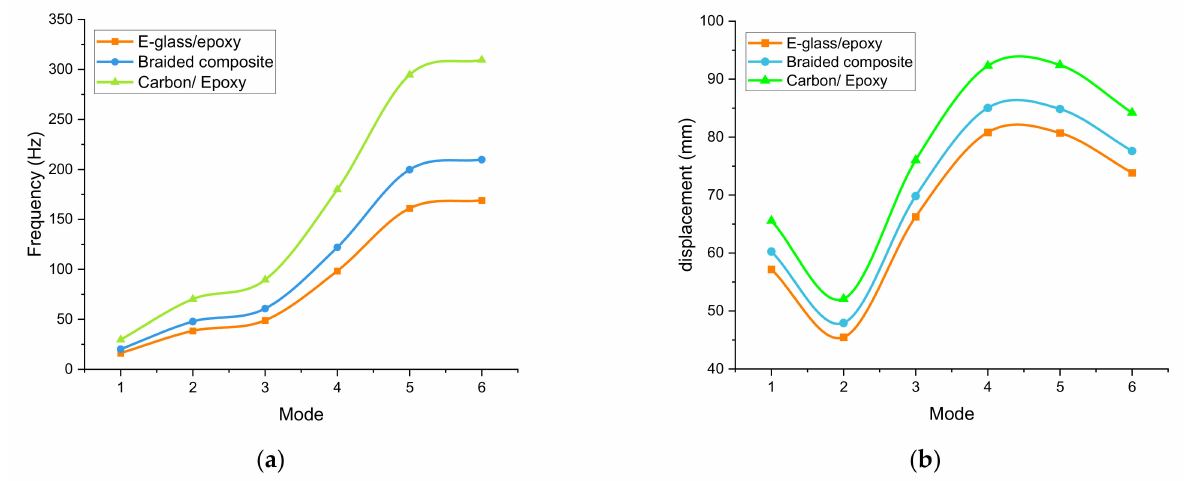
Figure 14. The variation of ( a ) natural frequency and ( b ) displacement with